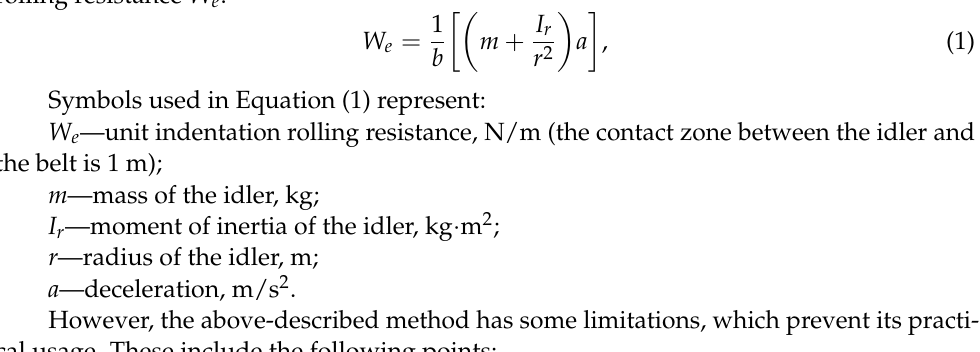
Figure 1. Schematic diagram illustrating measurements of the resistance of an idler rolling on the conveyor belt. The principle behind this measurement is as follows. A conveyor belt having a width B is placed on a rigid and even surface, with the bottom cover facing upwards. An appropriate idler having a mass m and a moment of inertia I r , normally engaged with such a belt on an actual conveyor, is rolled on the belt with a velocity V 1 . Due to the rolling resistances, the idler rolls on the belt with a negative acceleration, losing its velocity and reaching a velocity value V 2 . If the time t required by the idler to travel a distance s is measured, the result can serve to calculate the negative acceleration (the deceleration) of the idler, and subsequently, by following relationship (1), to find the unit indentation rolling resistance W e